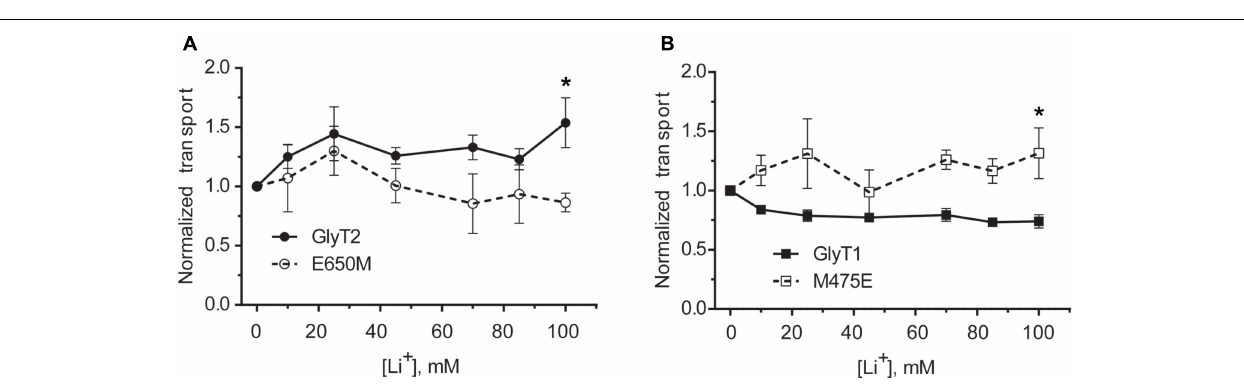
FIGURE 8 | Lithium dependence of glycine transport of wild-type GlyTs and mutant transporters. (A,B) COS7 cells expressing wild-type GlyT2 or GlyT2-E650M (A) or wild-type GlyT1 or GlyT1-M475E (B) were assayed for 3 [H]-glycine transport in HBS containing 30 mM NaCl concentration in every point and the indicated increased LiCl concentration up to 150 mM that was reached by isotonic supplementation with choline chloride. ∗ p < 0.05 Mann–Whitney